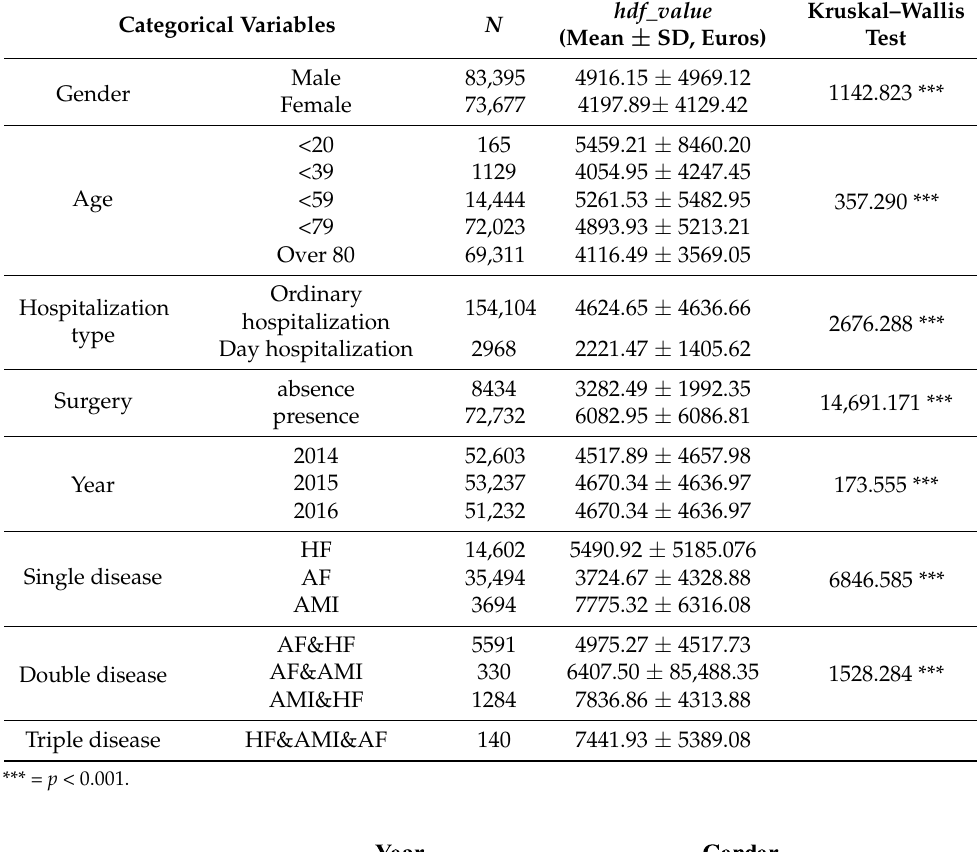
Table 3. Summary characteristics of hdf_value by each categorical factor.